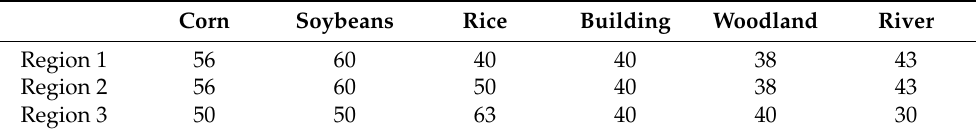
Table 2. Validation samples in each study